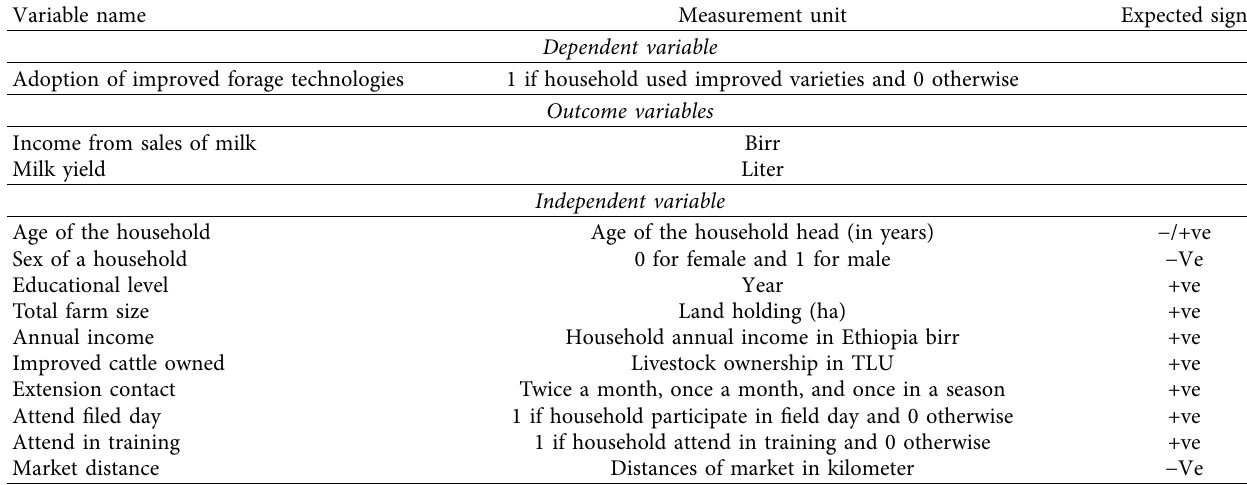
Table 2: Description, measurement, and expected sign of hypothesized